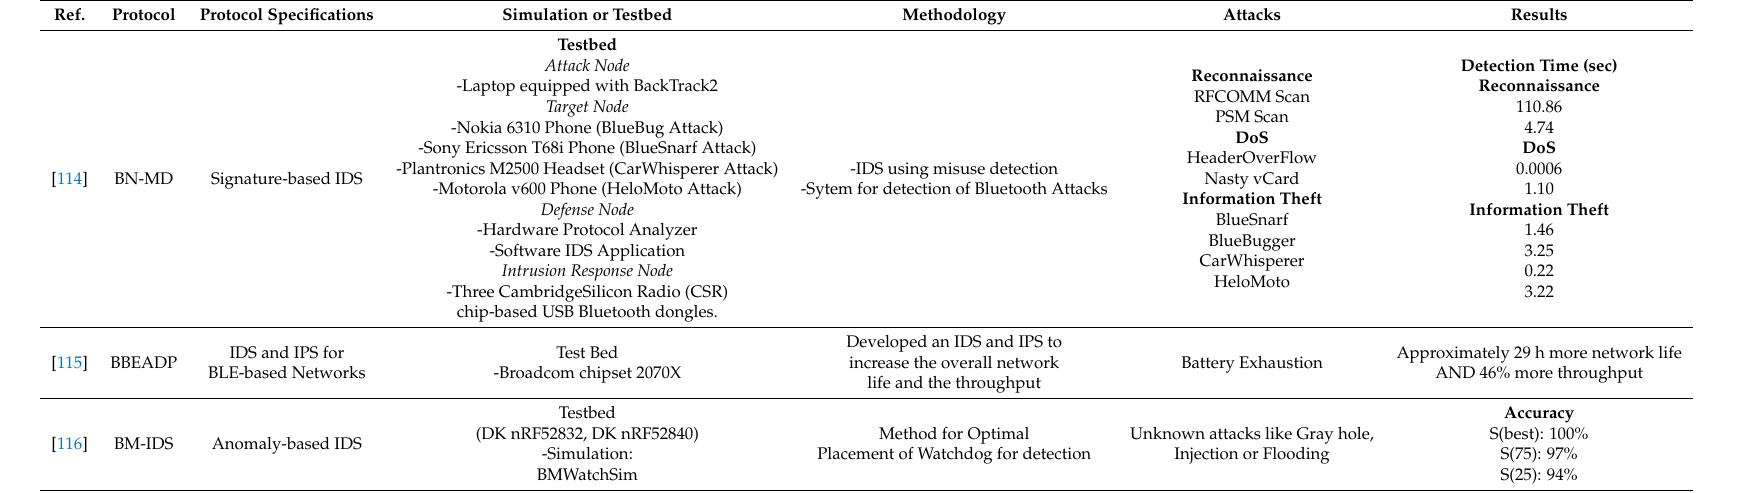
Table 6. Summary of IDS for BLE